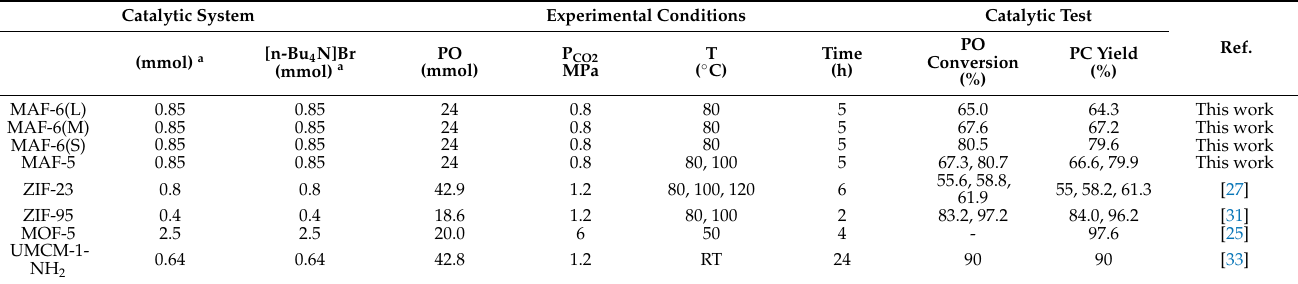
Table 2. Cycloaddition of CO 2 to propylene oxide in the presence of ZIFs/[n-Bu 4 N]Br binary systems. Catalytic